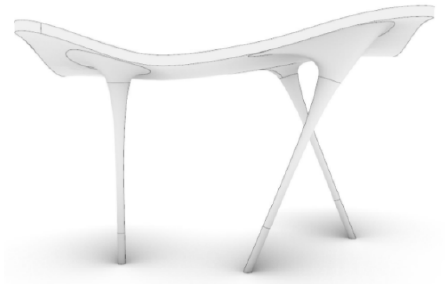
Figure 2. Concept of free-form structure.